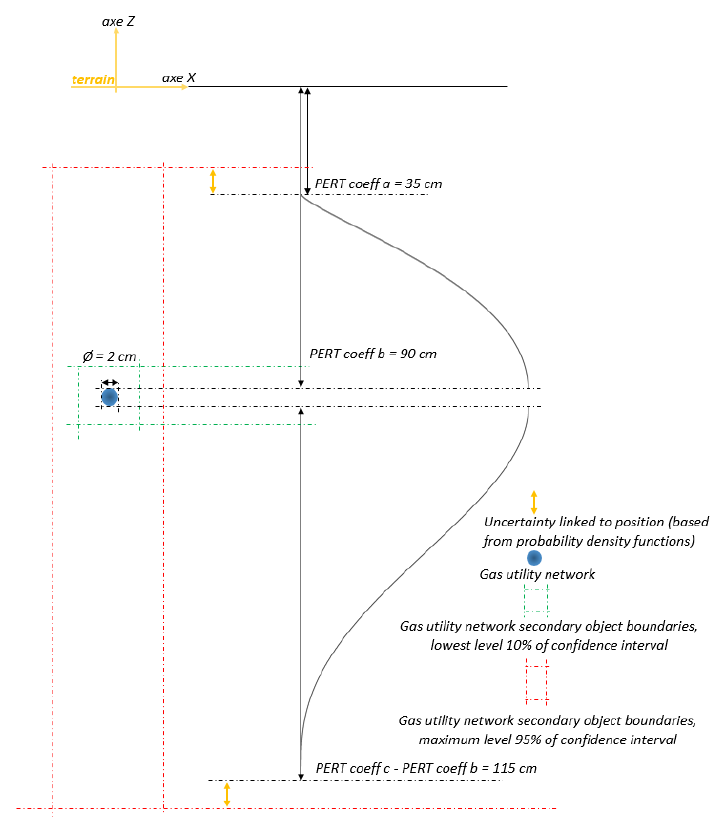
Figure 11. Bounding box for a natural gas network secondary object.